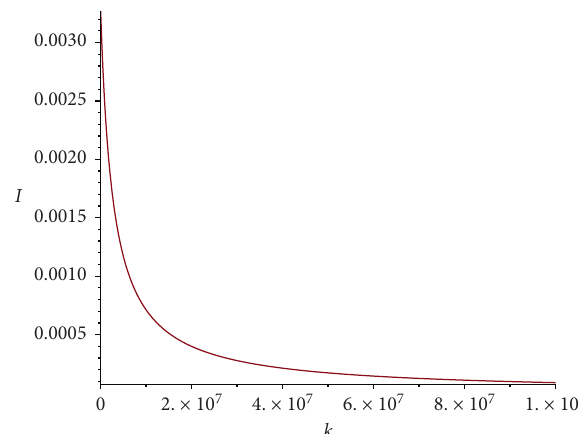
Figure 8: H 2 performance index with respect to stiffness coefficient for structure C1 under the excitation of El Centro seismic